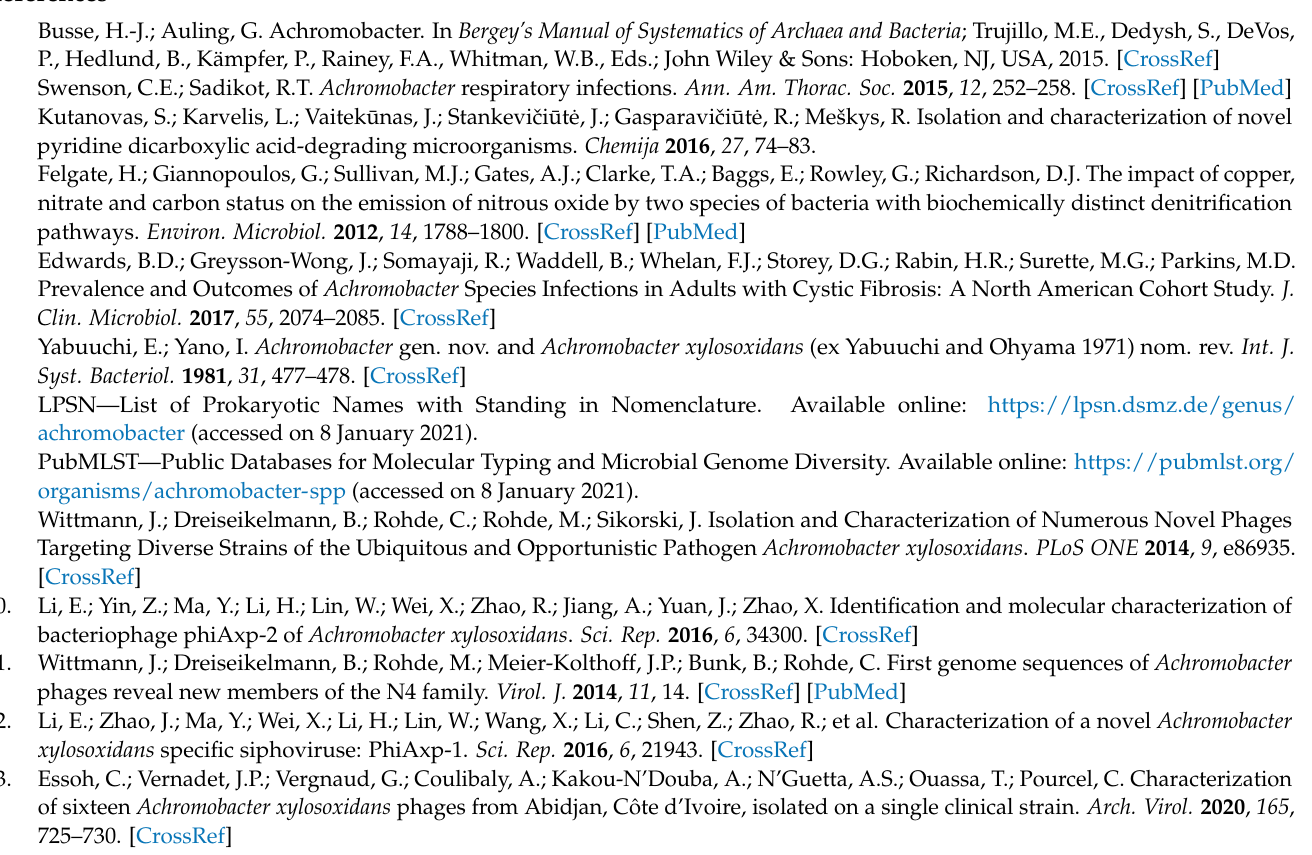
AchV4 genes. Table S3: list of regulatory sequences predicted by PhagePromoter. Table S4: Rho- independent terminators predicted by ARNold. Table S5: phage genomes used for the construction of proteome-based tree. Table S6: proteins shared between AchV4 and related phages as identified by CoreGenes 5.0. Table S7: Achromobacter phages with completely sequenced genomes. Figure S4: the average nucleotide and amino acid identities between Achromobacter phage genomes. Figure S5: proteomic tree generated based on the genome-wide similarity relationships between 30 Achromobacter bacteriophages and related viruses from the Virus-Host database. Figure S6: Splitstree representation of the unrooted phylogenomic GBDP tree. Figure S7. Schematic representation of the genome organization of Achromobacter